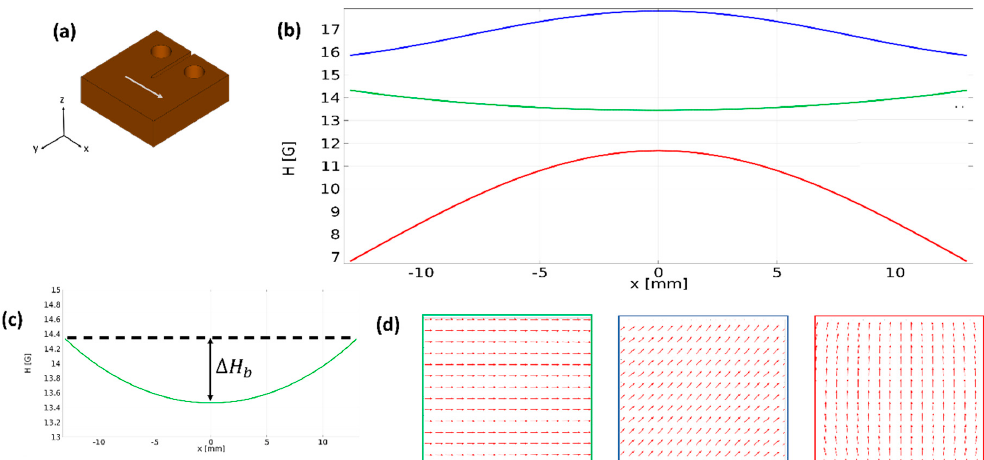
Figure 4. Calculation of the magnetic flux density and vector components using COMSOL MULTIPHYSICS. ( a ) White arrow indicates the directionality of the measurements along the X -axis of the specimen. ( b ) The profile of the field intensity in setup 3, involving a bias field and a concentration field. The blue curve indicates the profile of the field intensity, which is a superposition of the concentration field and the bias field. The red and green curves indicate the Z -component (originated from the concentration field) and the X -component (originated from the bias field) of the field intensity, respectively. ( c ) The profile of the field intensity while using only a bias field; note that the field intensity has some deviation from uniformity, which is maximal in the middle of the two magnets and denoted by ∆ H b . ( d ) The vector field in the XZ plane; the red caption referring to the vector field created by the concentration field, the green caption to the vector field created by the bias field, and the blue caption to the vector field created by setup 3 which is the superposition of the two fields.